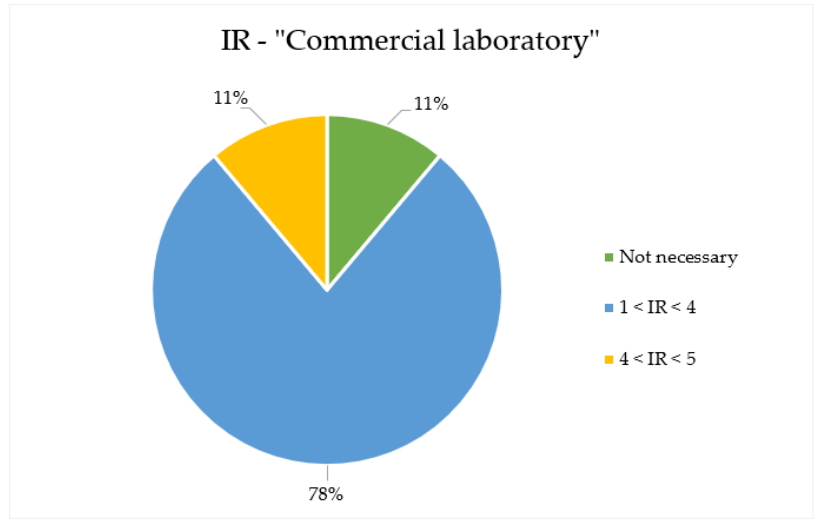
Figure 2. Percentage distribution of samples for IR evaluation (focusing on the “commercial labor- atory ” ).